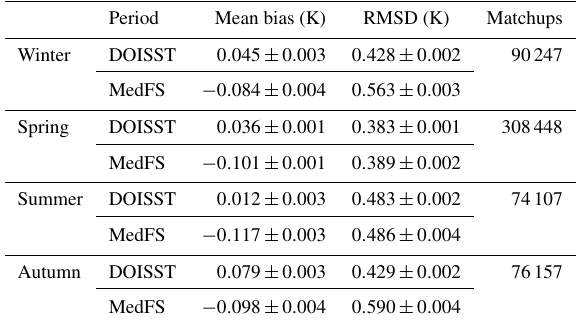
Table 5. Summary statistics of DOISST and MedFS SSTs. Mean bias (K) and RMSD (K) are derived from temperature differences against drifters’ data during winter (DJF), spring (MAM), summer (JJA), and autumn (SON) over the period 2019–2020. Each statis- tical parameter is associated with a 95% confidence interval com- puted through a bootstrap procedure (Efron and Tibshirani,